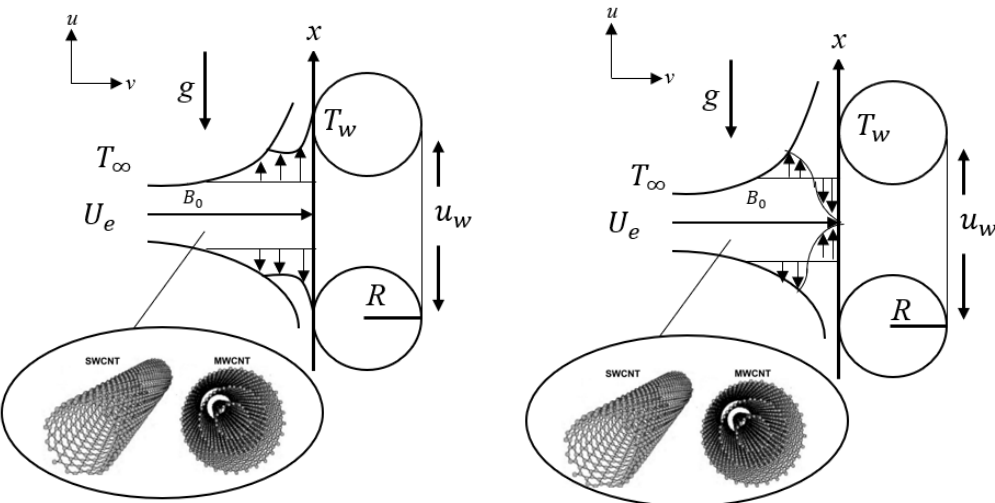
Figure 1. Physical model and coordinate system representation for vertical stretching/shrinking cylinder. Table 1. Base fluid and nanoparticles numerical values for thermophysical properties [50]. Thermophysical